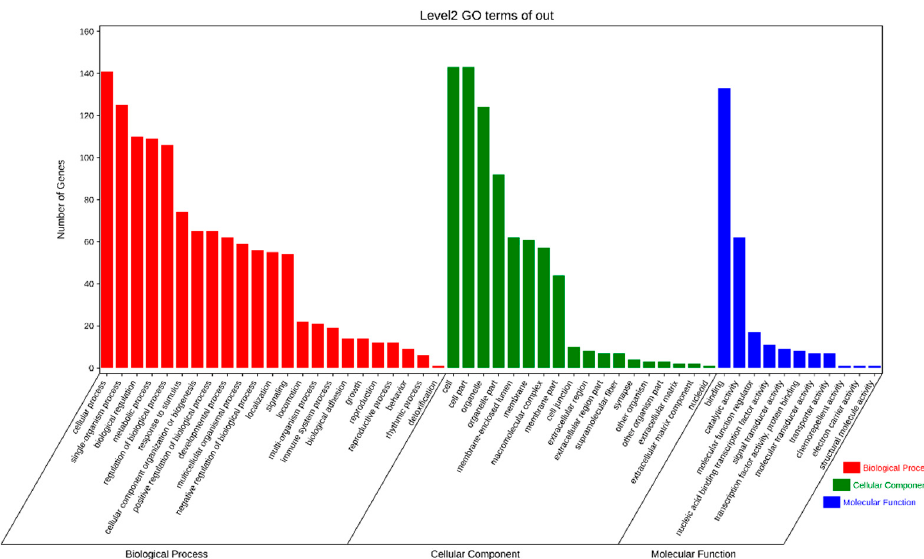
Figure 3. GO classification of differentially expressed genes.